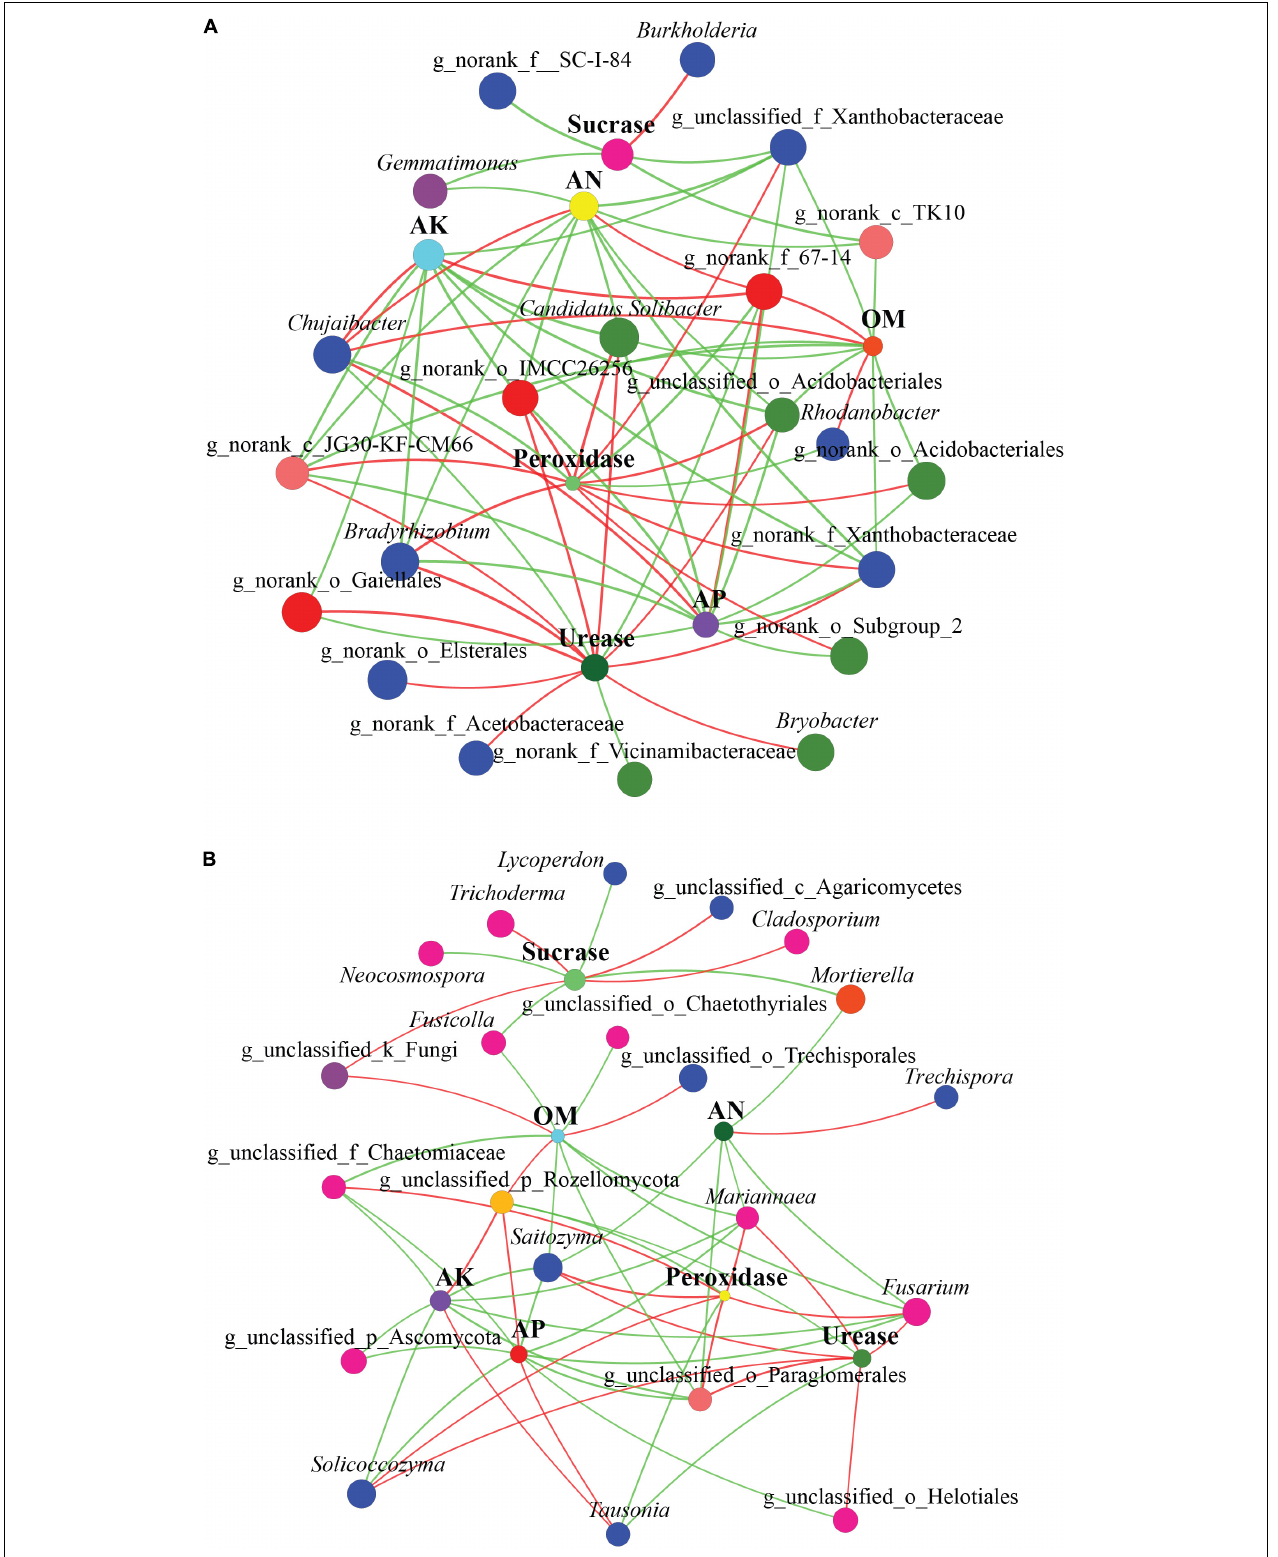
FIGURE 8 | Two-way co-occurring network analysis of soil characteristics, enzyme activity, and bacterial (A) and fungal (B) community within three forest types. The size of each node is proportional to the relative abundance. The colors of the lines indicate positive (red) and negative (green) correlations.